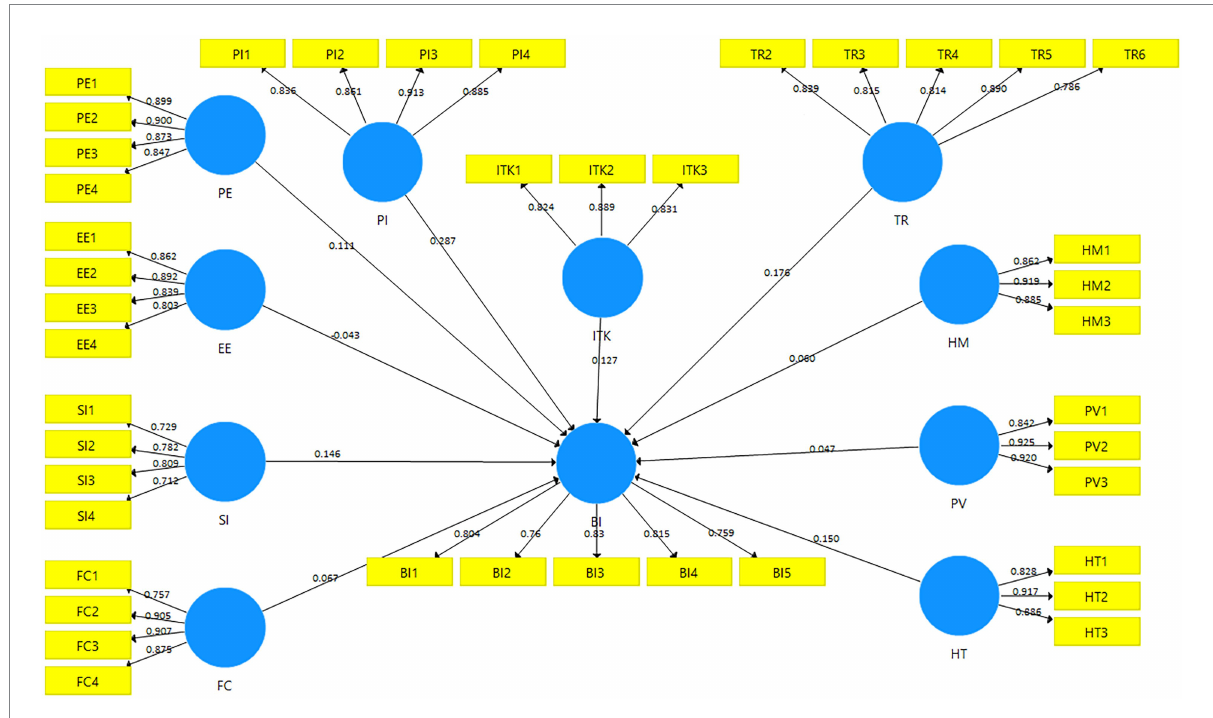
FIGURE 2 Structural